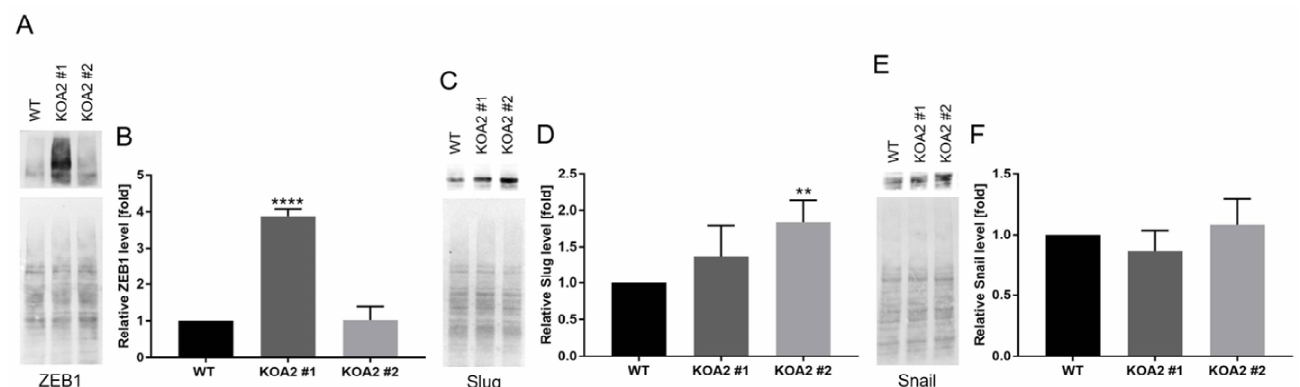
Figure 8. SLC35A2 knockout upregulates expression of selected EMT-TFs in MDCK cells. ( A , C , E ) West- ern blotting analysis of the levels of ZEB1 ( A ), Slug ( C ), and Snail € . Ponceau S stainings are presented alongside to demonstrate equal loading. Representative data out of several independent experiments are shown. ( B , D , F ) Densitometric analysis of the levels of ZEB1 (( B ), n = 3), Slug (( D ), n = 4), and Snail (( F ), n = 3). Data are presented as mean ± SD. Asterisks indicate statistically important differ- ences between wild-type cells and individual clones. The significance level was set at p ≤ 0.01 (**) and p ≤ 0.0001 (****). Data were analyzed using ordinary one-way ANOVA with post hoc (Tukey’s multiple comparisons)